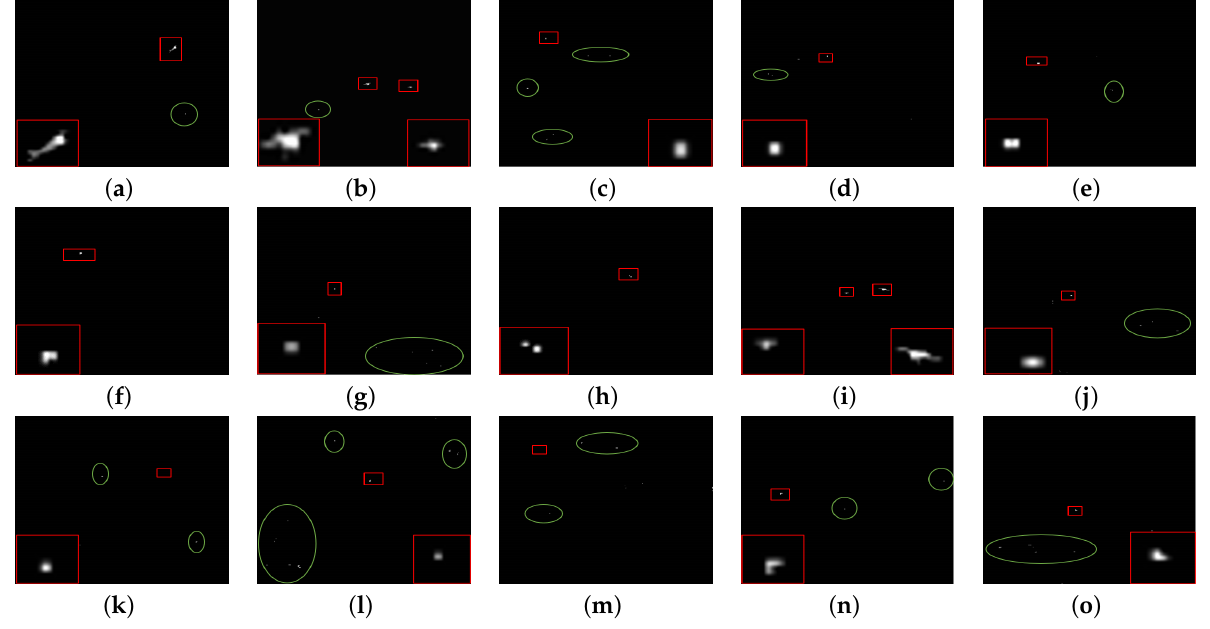
Figure 14. Targets detected in 15 different sequences by using PSTNN. ( a – o ) represent the corre- sponding scenes in Figure